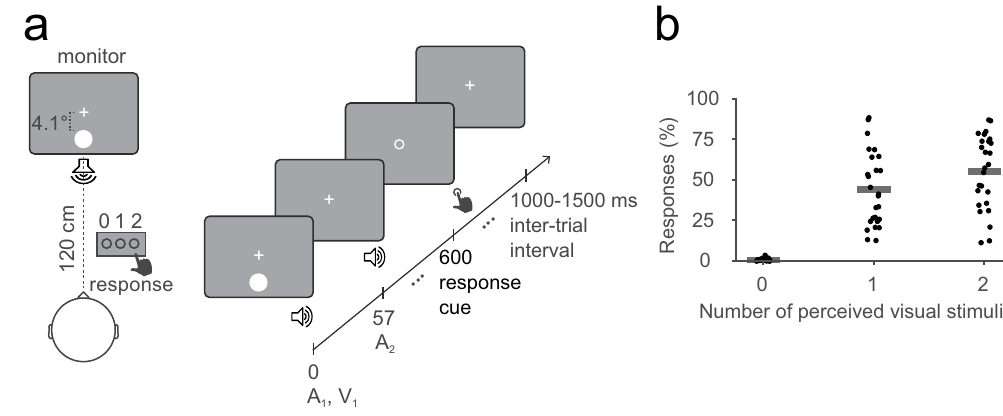
Figure 1. ( a ) Experimental design. ( b ) Response rates in the A 2 V 1 condition. Individual response rates are indicated by dots, the average is indicated by horizontal